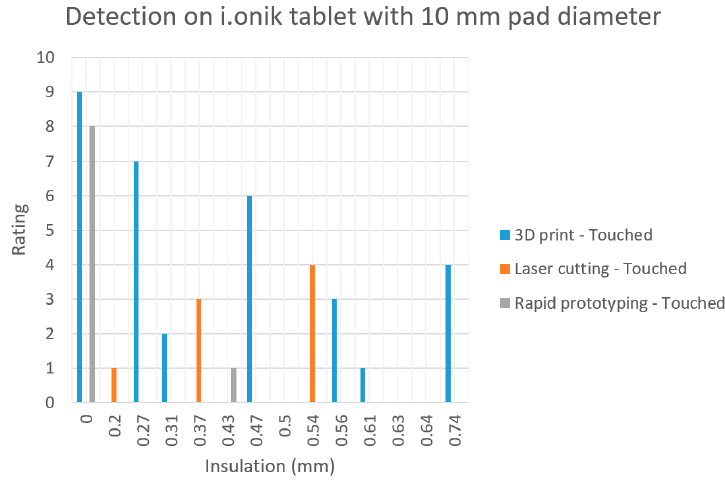
Figure 14. Detection performance (“Rating”) of different marker types with varying insulation layer using the large markers on the i.onik tablet.